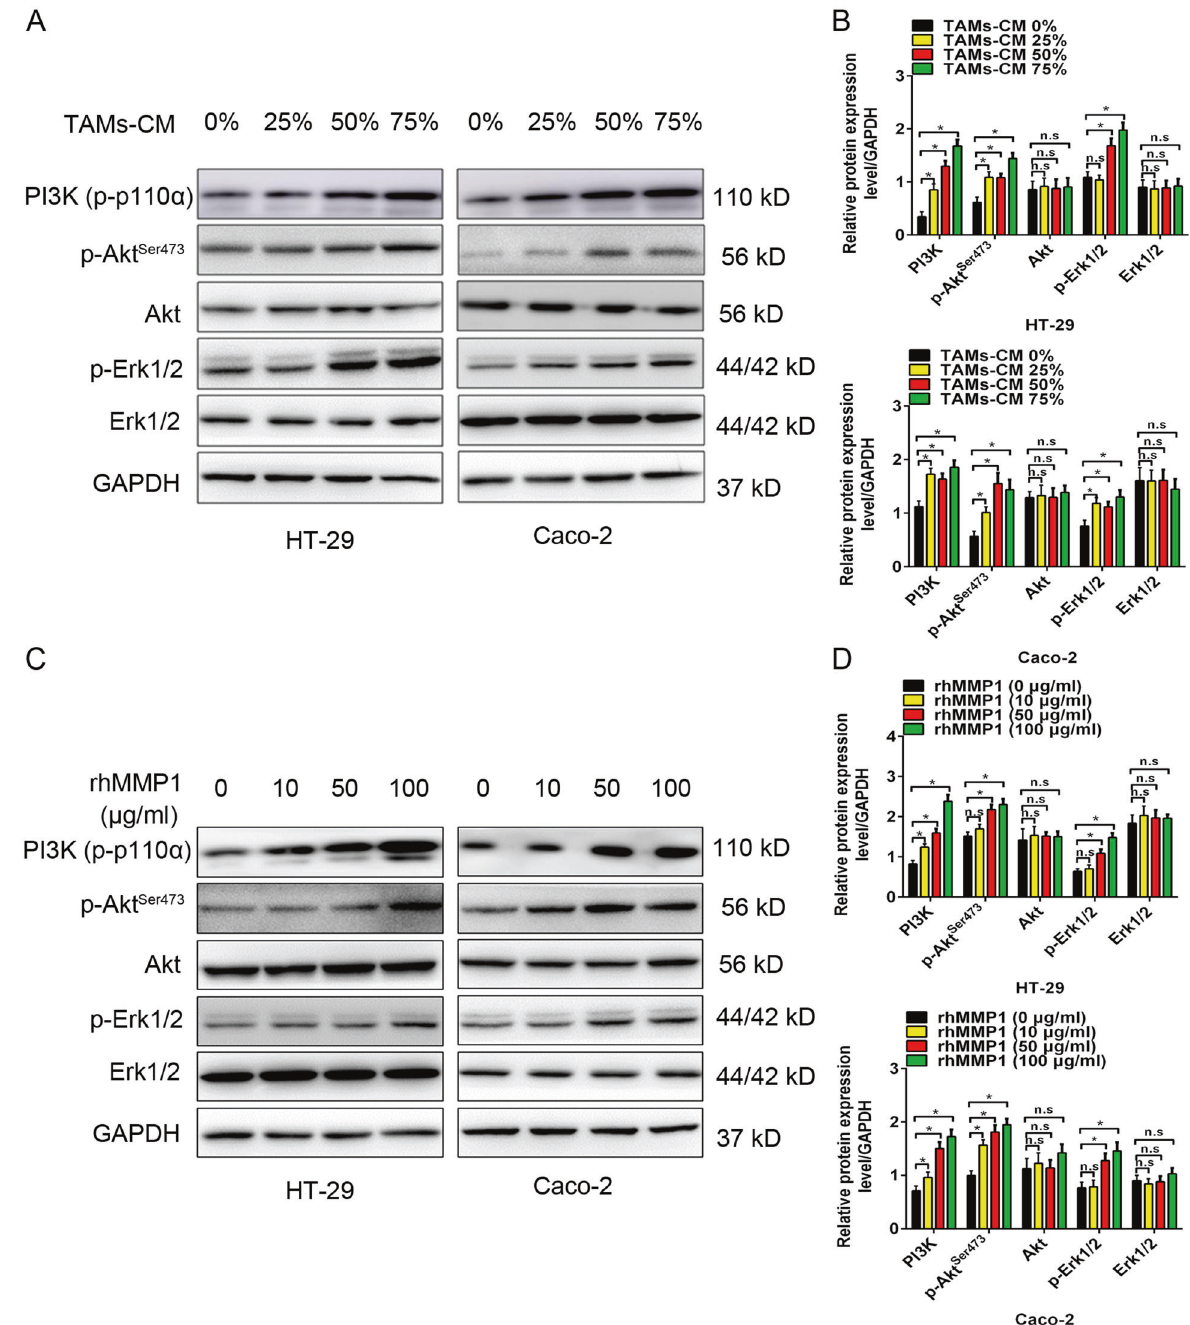
Fig. 4 MMP1 promoted the phosphorylation of Erk1/2 and Akt. A , C Western blotting analysis for PI3K/Akt and MAPK/Erk signaling in HT-29 and Caco-2 cells treated with 0, 25, 50, and 75% TAMs-CM ( A ) or 0, 10, 50, 100 μ g/ml rhMMP1 ( C ). B , D Comparison of the protein levels in HT- 29 and Caco-2 cells treated with 0, 25, 50, and 75% TAMs-CM ( B ) or 0, 10, 50, 100 μ g/ml rhMMP1 ( D ). All data are presented as the mean ± SD from three independent experiments. * P < 0.05. incubation or rhMMP1 treatment (Supplementary Figs. 5a, b and 6a, b). Western blotting analysis revealed that SCH772984 Similar results were observed in HT-29 and Caco-2 cells with treatment reduced the protein levels of cyclin A2, cyclin B1, cyclin rhMMP1 treatment (Fig. 4C, D). D1, c-Myc, and ETV4 but elevated the protein levels of p21 To further determine that PI3K/Akt and MAPK/Erk pathways (Supplementary Figs. 5c, d and 6c, d). No signi fi cant alteration of were responsible for MMP1/PAR1 axis-induced proliferation of cell cycle-related proteins was observed upon MK-2206 treatment. colon cancer cells, an Erk1/2 inhibitor (SCH772984) and an Akt Likewise, treatment with PAR1 inhibitor MK-5348 inhibited the inhibitor (MK-2206) were applied in the present study. Treatment expression of p-Erk1/2 but did not affect p-Akt (Supplementary with SCH772984 but not MK-2206 suppressed the accelerative Figs. 5c, d and 6c, d). Altogether, these fi ndings suggested that proliferation of HT-29 and Caco-2 cells induced by TAMs-CM Cell Death Discovery (2021)